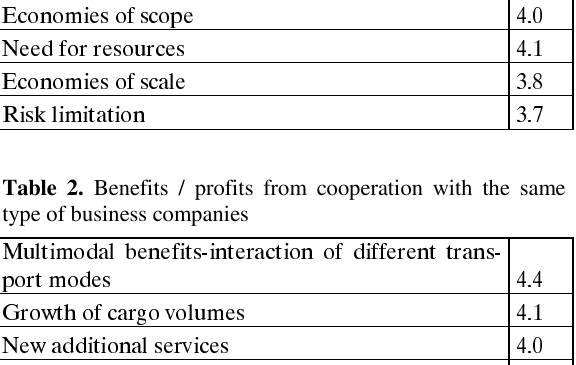
Table 1. Motives for cooperation with the same type of business companies Economies of scope